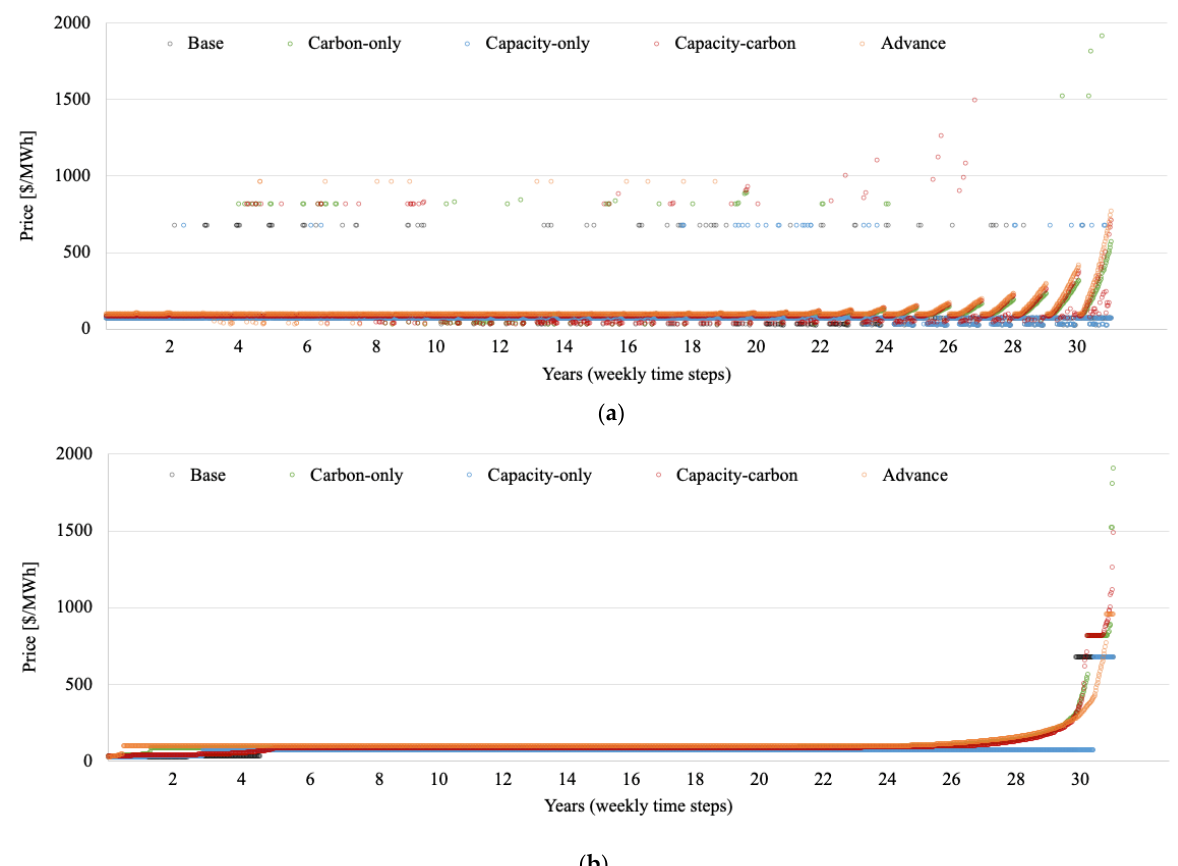
Figure 16. ( a ) The change in electricity price; ( b ) the sorted electricity price.